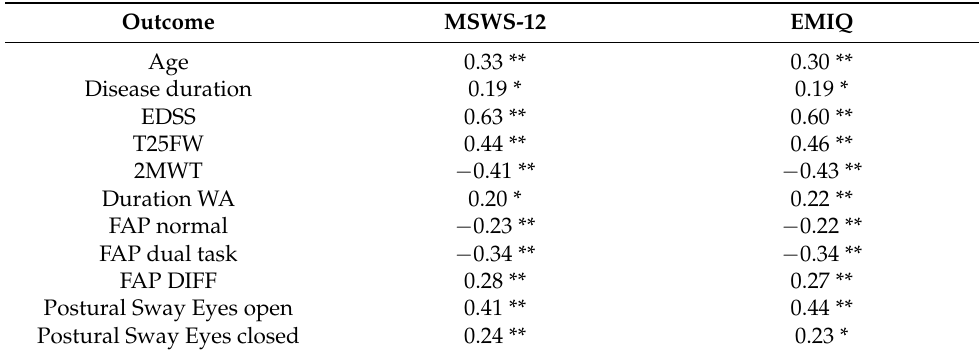
Table 3. Kendall’s Tau-b ( τ ) correlation between demographic data, patient-reported outcome measures, and clinical outcomes ( N = 105).